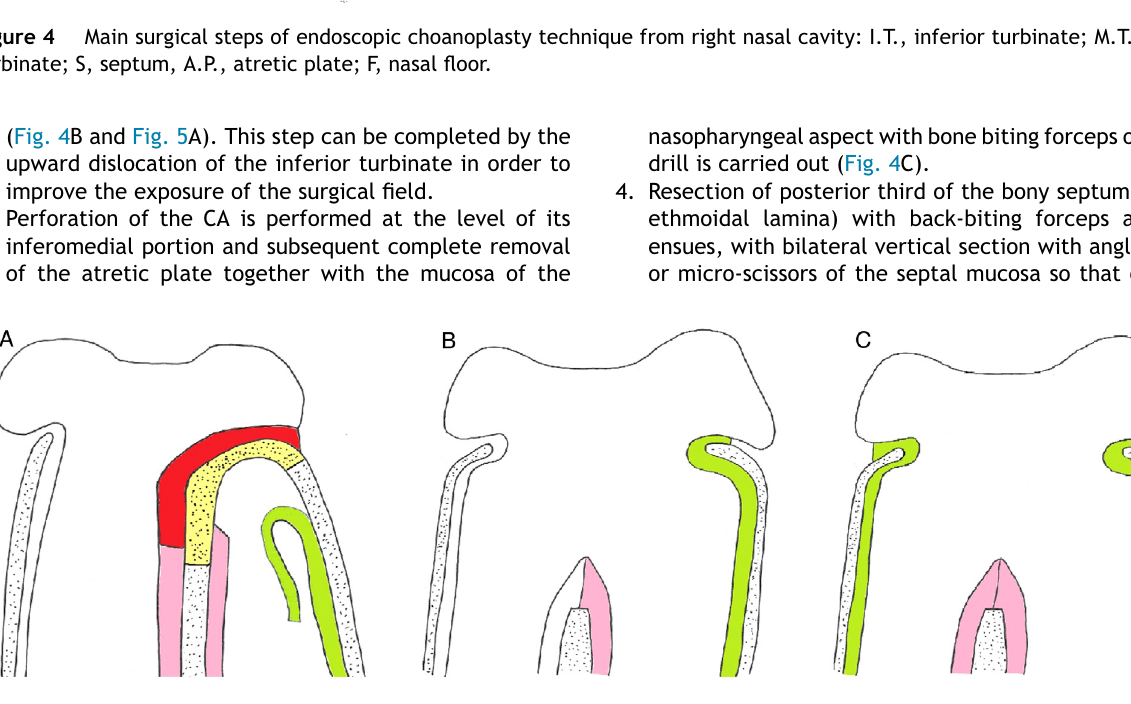
Figure 5 Laterally elevation of the mucoperiosteal flap and exposition of the atretic bony plate (A). Repositioning of the lateral mucosal flap covering the lateral nasal wall after removal of the atretic plate in case of monolateral (B) and bilateral atresia (C); atretic plate (yellow); mucosa of the posterior face of the atretic plate (red); mucosal flap laterally displaced (green); septal mucosa of each side